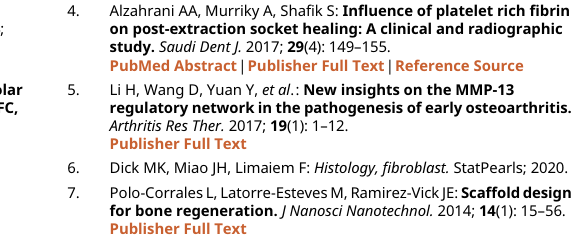
Figshare: ARRIVE checklist for ‘ Pre-Clinical Study: Immunohistochemical evaluation of matrix metalloproteinase-13 on Rabbit (Oryctolagus cuniculus) socket healing after application of platelet-rich fibrin with and without hydroxyapatite ’ https://doi.org/10.6084/m9.figshare.16640299. 16